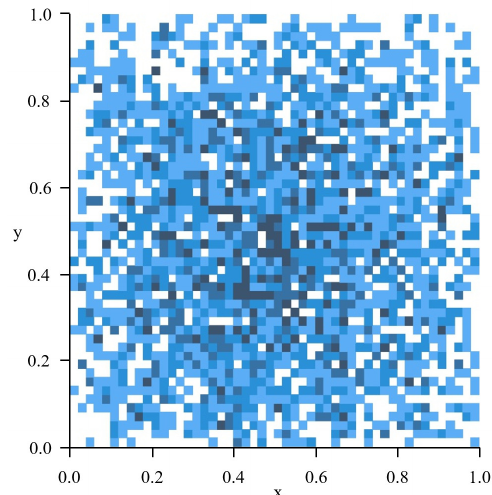
Figure 4 . 2D histogram of bounding box pixel coordinates.